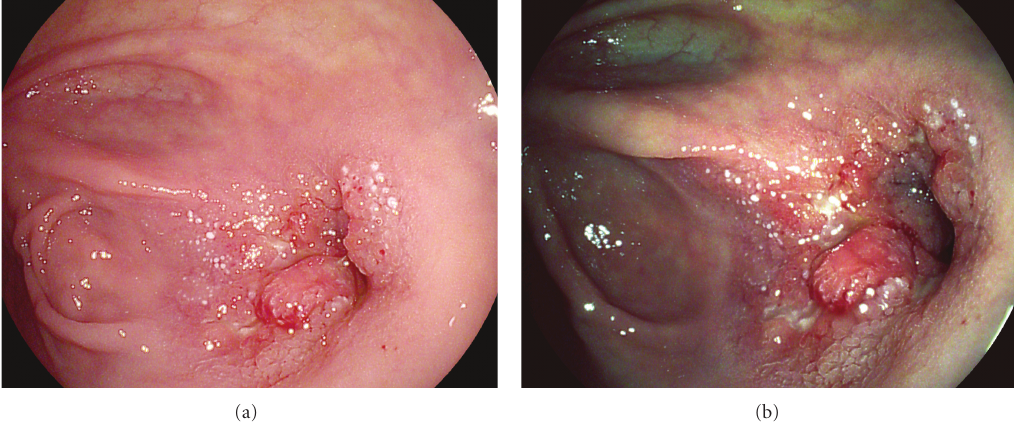
Figure 4: (a) highlights high-definition white-light endoscopic picture of anastomotic stricture in a patient su ff ering from Crohn’s disease. (b) shows virtual chromoendoscopy with i-scan to better characterize the stricture. i-scan revealed enhanced vasculature and fibrinous lesions consisting with an active inflammation.